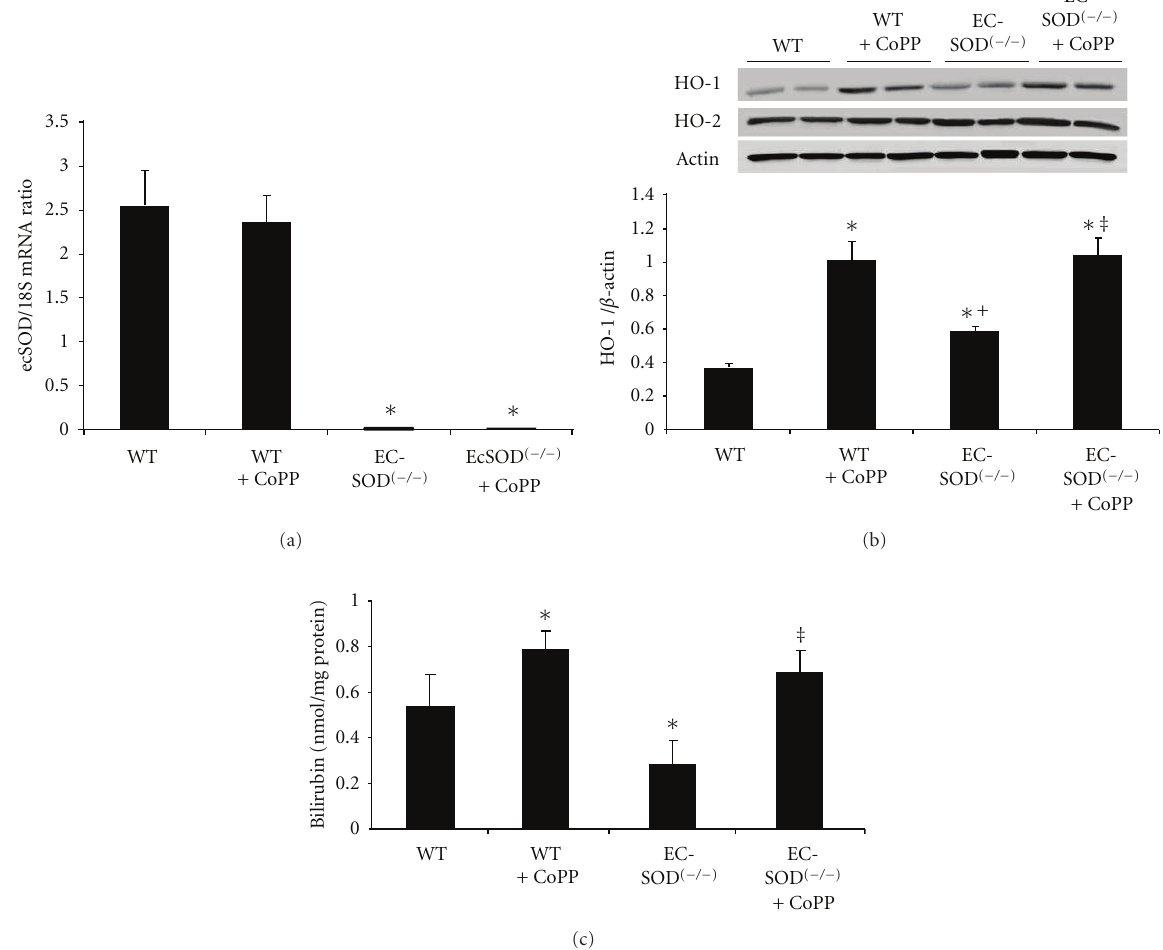
∗∗ Figure 1: (a) Detection of EC-SOD mRNA transcripts by RT-PCR analysis in renal tissues. EC-SOD ( − / − ) animals demonstrated significant ( P < 0 . 05) reduction in EC-SOD mRNA as compared to their WT counterparts, and the administration of CoPP had no significant e ff ect on SOD3 mRNA levels in both WT and KO animals. Results are expressed as mean ± SE, ∗ P < 0 . 01 versus WT mice. (b) Western blot analysis of HO-1 and HO-2 proteins in kidney homogenates of WT and EC-SOD ( − / − ) mice. Immunoblots were performed using antibodies against mice HO-1 and HO-2 proteins. Blots are representative of six separate experiments. Results are expressed as mean ± SE, ∗ P < 0 . 01 versus WT, + P < 0 . 05 versus WT + CoPP, ‡ P < 0 . 05 versus EC-SOD ( − / − ) . (c) Bilirubin production in WT, EC-SOD ( − / − ) mice and EC-SOD ( − / − ) mice treated with CoPP. Values are expressed as the mean ± SD of 4 experiments, ∗ P < 0 . 05 versus WT mice, ‡ P < 0 . 01 versus EC-SOD ( − / − )